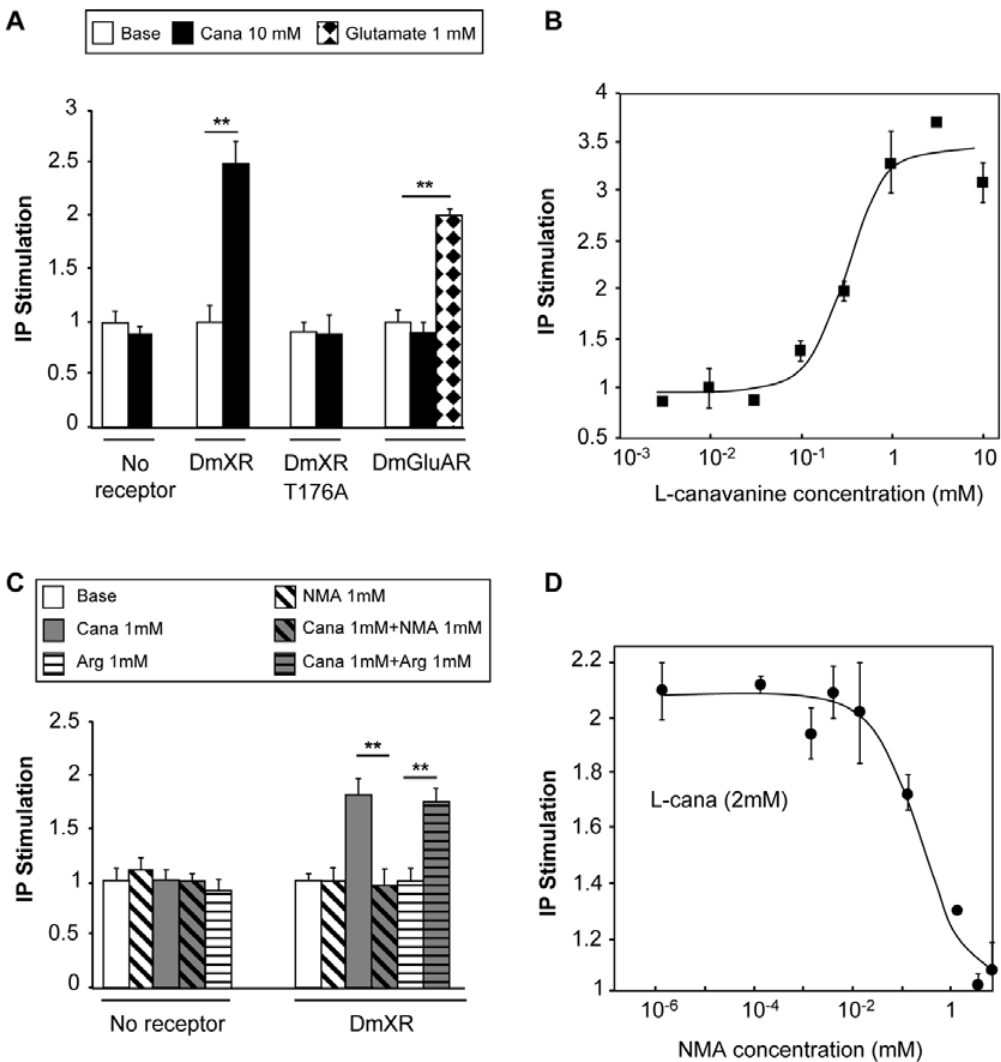
Figure 1. L -Canavanine activates DmXR and N -methyl- L -arginine (NMA) inhibits DmXR. (A) L -Canavanine (Cana) is an agonist of DmXR. L - Canavanine at a concentration of 10 mM (black) activated DmXR in HEK cells, but had no effect on the unique fly metabotropic glutamate receptor DmGluA, which was activated by 1 mM glutamate (checkered). Note that 10 mM L -canavanine did not activate the DmX ligand binding pocket mutant receptor (DmXRT176A). (B) Dose-response curve of L -canavanine on DmXR. IP production by DmX receptors activated with increasing concentrations of L -canavanine (half-maximal effective concentration [EC 50 ] of L -canavanine=0.5 6 0.2 mM). (C) N -methyl- L -arginine (NMA) inhibits DmXR. The activation of DmXR by 1 mM L -canavanine (grey) was completely inhibited by 1 mM NMA (diagonally hatched on grey background). Thus NMA, which has no effect by itself (diagonally hatched on white background), is a potent antagonist of DmXR. L -arginine (1 mM) did not activate DmXR (horizontally hatched on white background) nor antagonize 1 mM L -canavanine effect on DmXR (horizontally hatched on grey background). (D) Dose-response curve of NMA antagonistic effect on DmXR. IP production by DmX receptors activated with 2 mM L -canavanine ( L -cana) in the presence of increasing concentrations of the antagonist NMA (half-maximal inhibitory concentration [IC 50 ] of NMA=0.2 6 0.2 mM). For (A–D), data are expressed as the IP (inositol triphosphate) production in HEK cells coexpressing a chimeric G-protein a -subunit Gqi9 and the indicated receptor in presence of drugs relatively to IP production in the basal conditions. The vertical bars represent the standard error of the mean (SEM of triplicate determinations from typical experiments). Asterisks indicate significant differences by t -test ( p , 0.001). doi:10.1371/journal.pbio.1000147.g001 effect increased with concentration, reaching a plateau at 30– colored by two food dyes (blue or red) offered simultaneously to 40 mM. At these concentrations, the PI for the blue solution is adult fly populations [29]. After 2 h in the dark, flies are counted 0.13 6 0.06 (Figure 2). A similar repulsive effect of L -canavanine on the color dye witnessed in their abdomen. In the control situation, WT flies preferred the blue solution, the preference was also visible when the drug was added to the red solution index (PI) being 0.82 6 0.04 (Figure 2). We then added increasing (unpublished data). To determine whether this repulsive effect was concentrations of L -canavanine to the blue solution (1 mM to mediated by a chemosensory mechanism, we used flies carrying an adult-viable mutant allele of the pox-neuro ( poxn ) gene. In 40 mM). We found that L -canavanine inhibited the intake of the homozygous poxn flies, external chemosensilla are deleted or blue solution (Figure 2), leading to a symmetrical increase in the transformed into mechanosensilla [30,31]. poxn flies fed equally on intake of the red solution (unpublished data). The L -canavanine